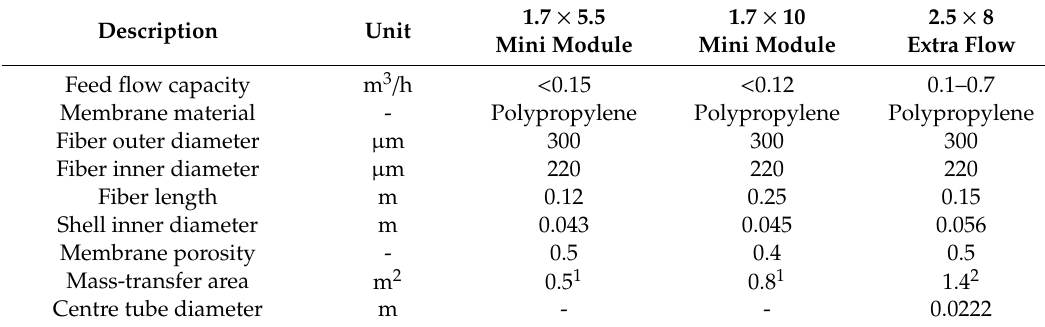
Table 1. Characteristics of the HFMC modules